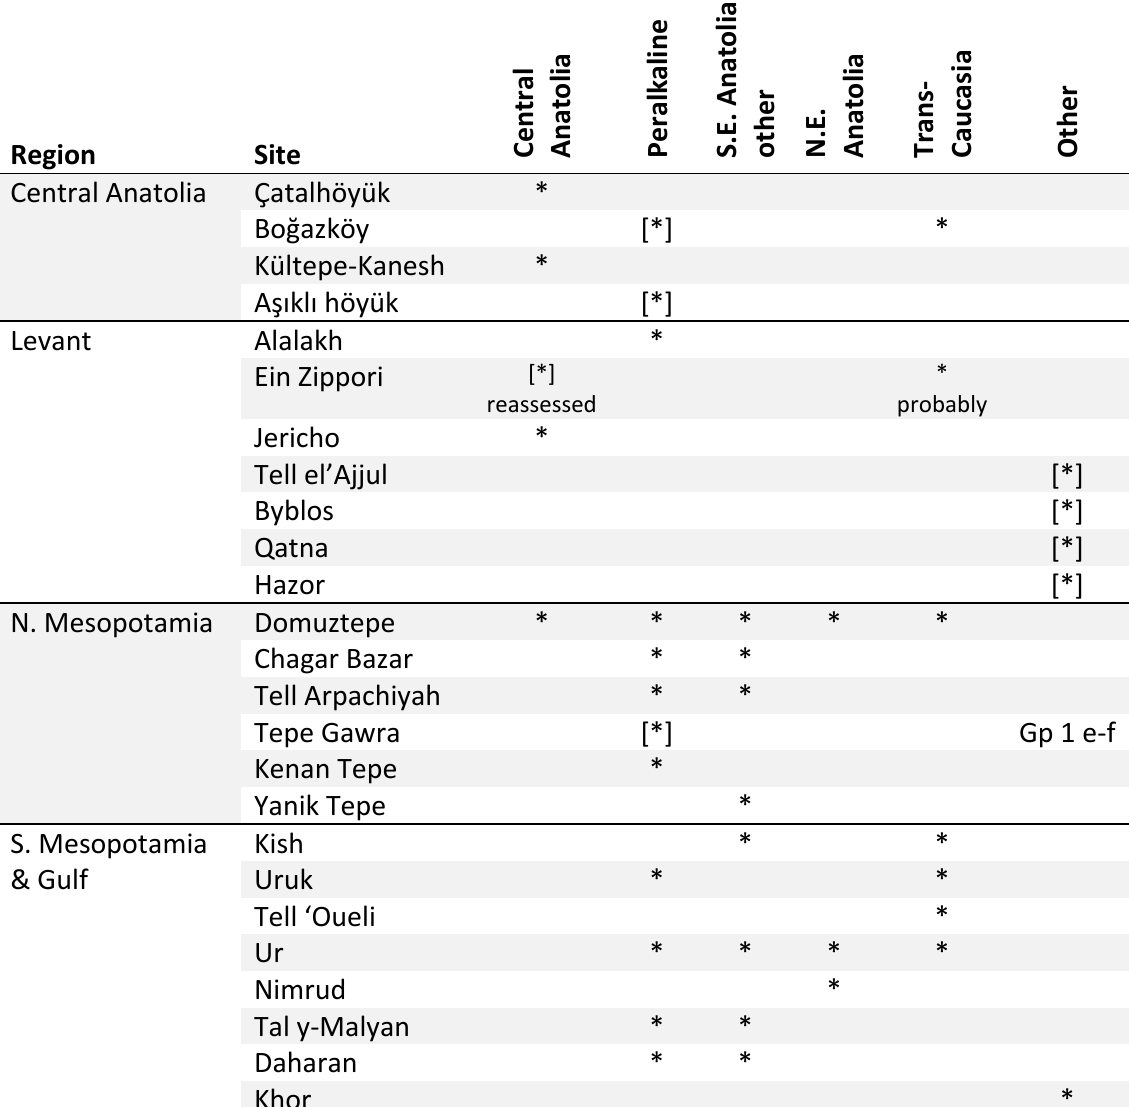
Table 2. Sites from which objects have been provenanced (*: geochemical attribution; [*]: visual attribution). References to provenance analyses may be found in Supplementary file